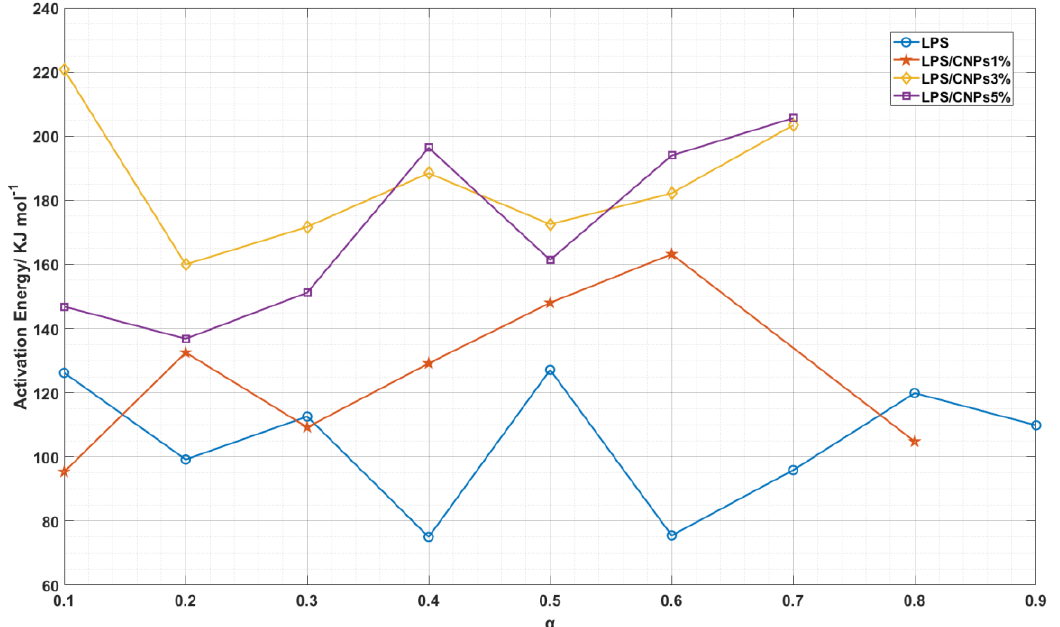
Figure 8. Variation of activation energy of neat LPS and LPS/CNPs nanocomposites versus conversion percentage.